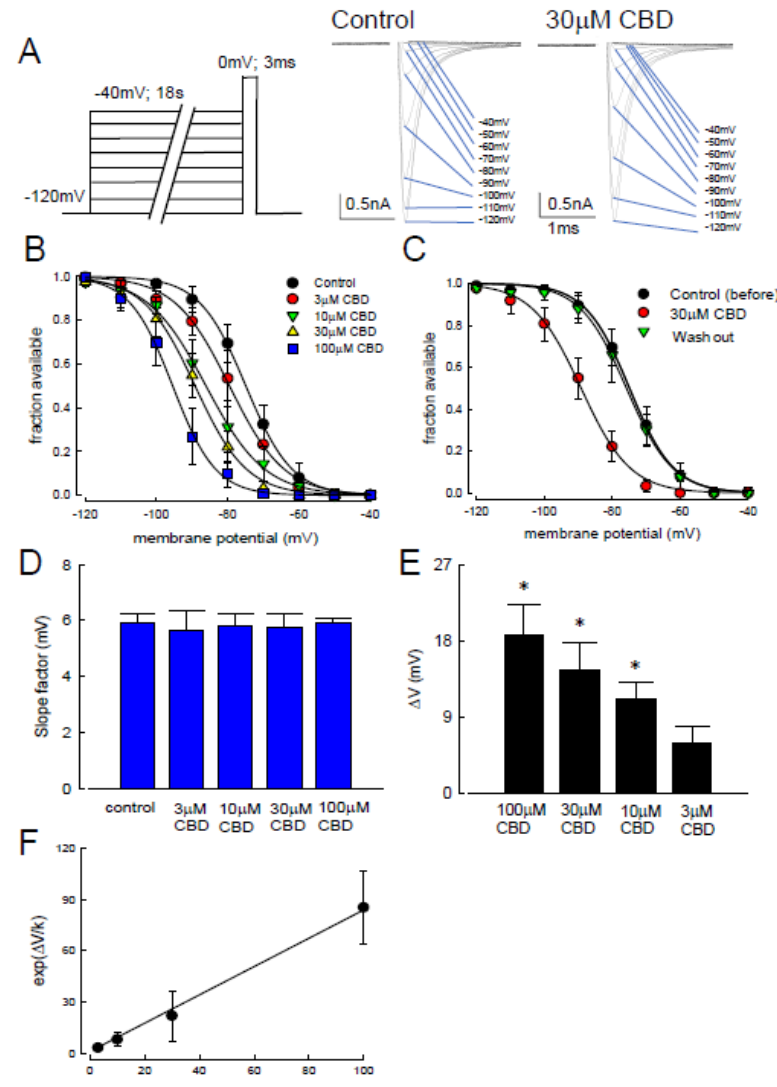
Figure 3. Changes in the slow-inactivating curve after the applications of cannabidiol. ( A ) The experiment protocols were similar to those of Figure 2, however, the duration of inactivation pulse was protracted to 18 s (left panel). The representative current sweeps for slow-inactivation of Na v 1.4 in the control channels and those treated with 30 µ M of CBD were recorded after the short test pulse (right panel). ( B ) The inactivating curve was shifted left in a dose-dependent manner after treatment with different concentrations of CBD. No significant change in slope was found in these curves. Lines of best fit were fitted using the Boltzmann function 1/(1 + exp[(V − V h )]/ k ), where V h were − 74.9 ± 0.4, − 79.5 ± 0.6, − 83.1 ± 0.5, − 89.2 ± 0.6, and − 95.5 ± 0.4 mV, and k values were − 6.5 ± 0.3, − 7.6 ± 0.5, − 8.4 ± 0.4, − 7.2 ± 0.4, and − 6.0 ± 0.3 for the control channels and those channels treated with 3, 10, 30, and 100 µ M of CBD, respectively. ( C ) The inactivation curves in the control channels, those treated with 30 µ M of CBD, and those after washing out. There was a hyperpolarized shift of the inactivation curve in those channels upon treatment with 30 µ M of CBD. Lines are fit using the Boltzmann function 1/(1 + exp [(V − V h )]/ k ), where V h were − 7.4 ± 0.4, − 89.2 ± 0.6, and − 75.9 ± 0.5 mV, and k values were − 6.5 ± 0.3, − 7.2 ± 0.45, and − 6.8 ± 0.37 for the control channels, those with 30 µ M CBD, and the washing out channels, respectively. ( D ) CBD did not significantly change the slope factor k. Cumulative results showed that the average values in the control channels and those channels after treatment with 3, 10, 30, and 100 µ M of CBD were 5.8 ± 0.3, 5.6 ± 0.7, 5.8 ± 0.4, 5.7 ± 0.5, and 5.9 ± 0.1, respectively. ( E ) A dose-dependent shift in V h for the inactivation curve. Comparing to the controls, the degree of voltage shift was 5.9 ± 1.9, 11.1 ± 1.9, 14.5 ± 3.3, and 18.7 ± 3.6 mV for those channels after treatment with 3, 10, 30, and 100 µ M of CBD, respectively, (*, p < 0.05). ( F ) The exp( ∆ V/k) values are plotted against the concentration of CBD. ∆ V/k were derived from mean values Figure 3D,E. The line is a best fit to the data of the formula exp( ∆ V/k) = 1 + ([CBD]/1.3), where the y-intercept is 1. The [CBD] denotes the CBD concentration in µ M